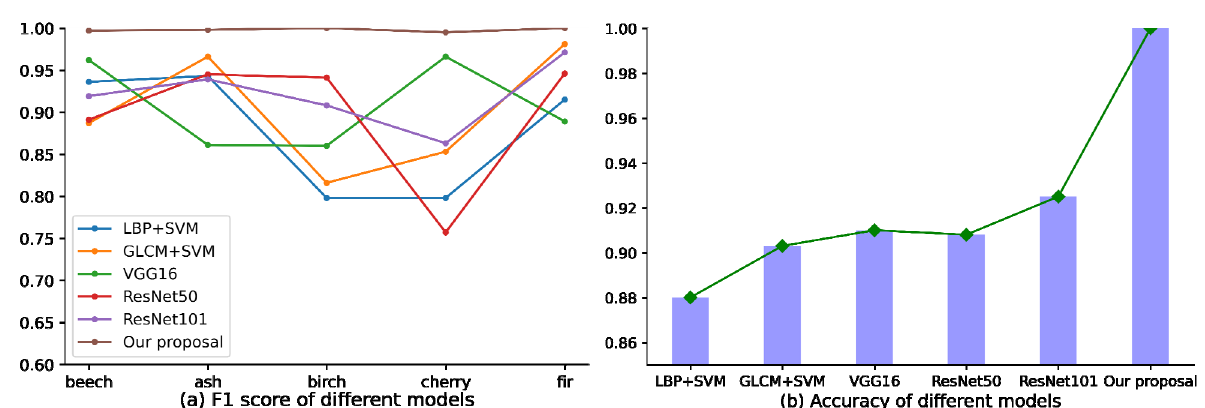
Figure 8. F1 score and Accuracy of different models in the identification of sawn timber species.